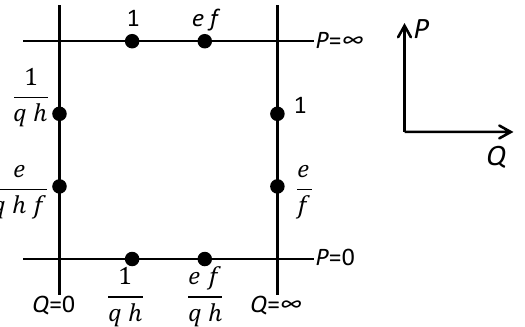
Figure 6 . Asymptotic values for parameters ( h; e; f ) in the three-dimensional space of brane con(cid:12)gurations C B